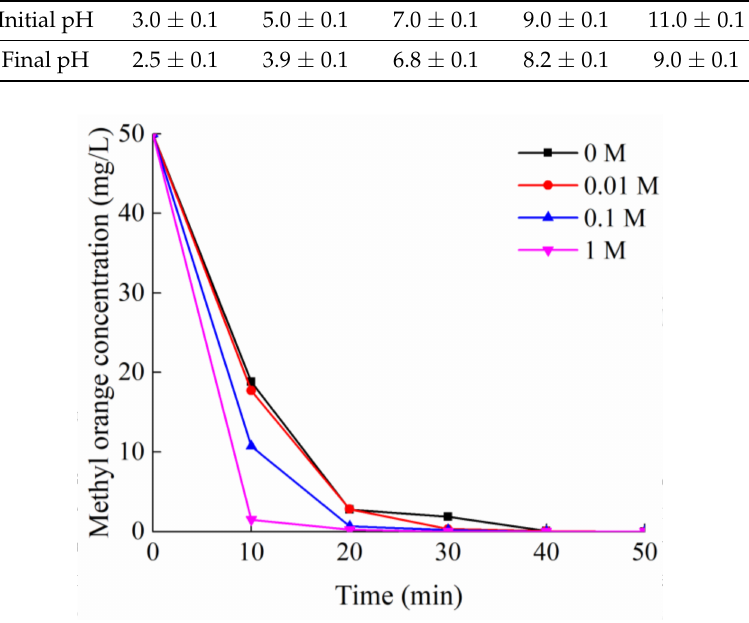
Figure 4. Effects of salinity on the treatment of methyl orange by ozone